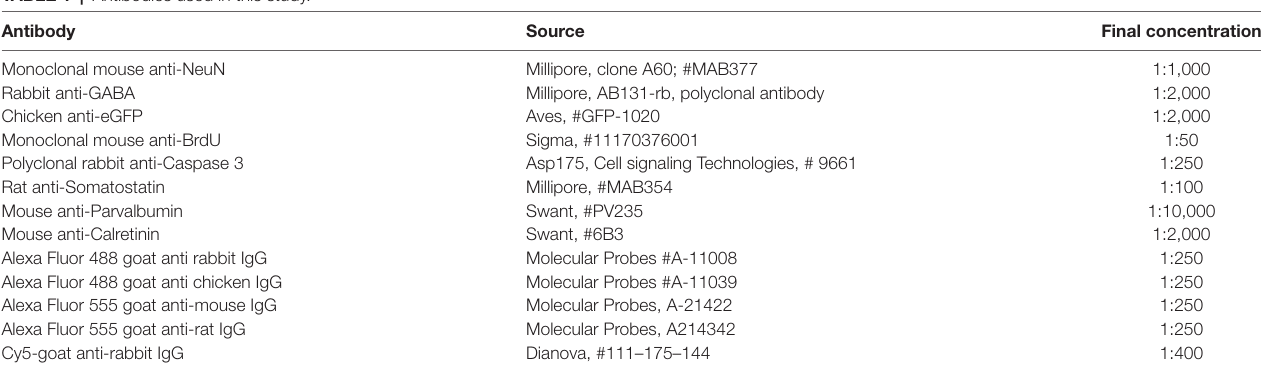
Source and dilutions of antibodies used for